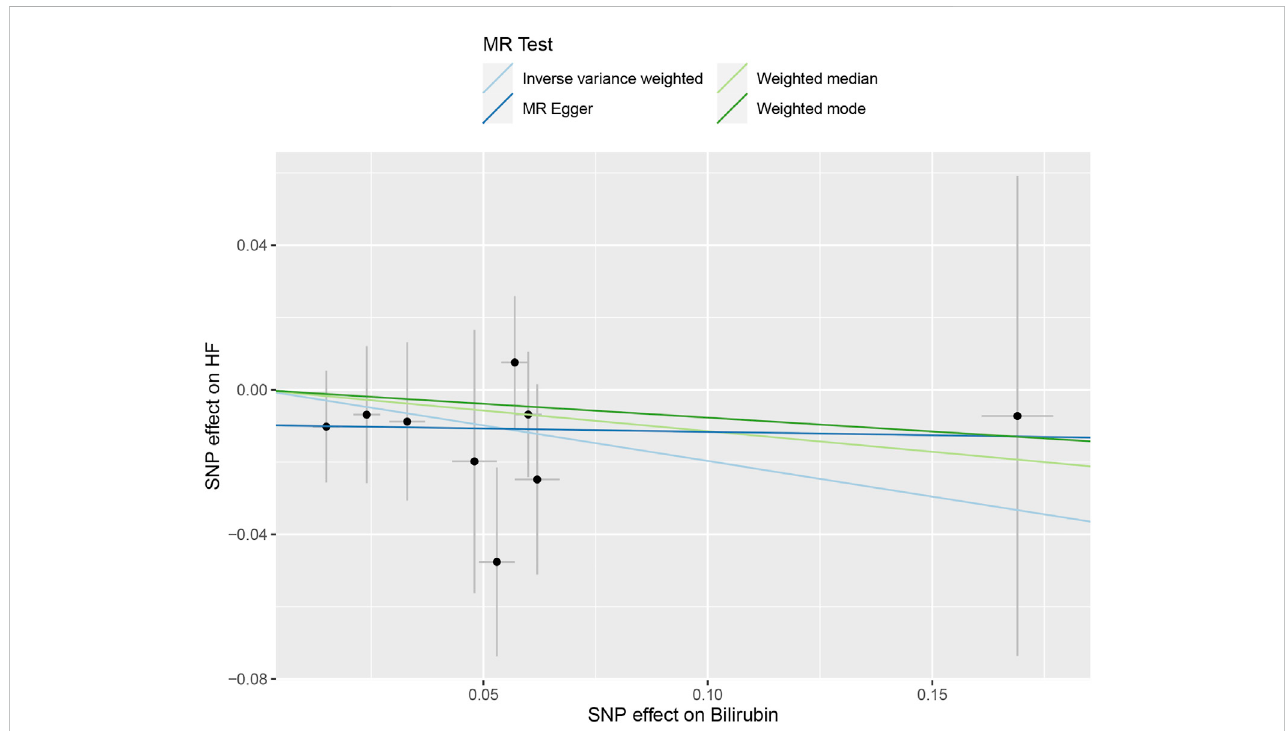
FIGURE 3 Thescatterplotofserumbilirubin-associatedsinglenucleotidepolymorphisms(SNPs)effectsonheartfailure(HF)intheBioBankJapancohort.The95% CI for the effect size on HF is shown as vertical lines, while the 95% CI for the effect size on bilirubin level is shown as horizontal lines. The slope of fi tted lines represents the estimated Mendelian randomization (MR) effect per